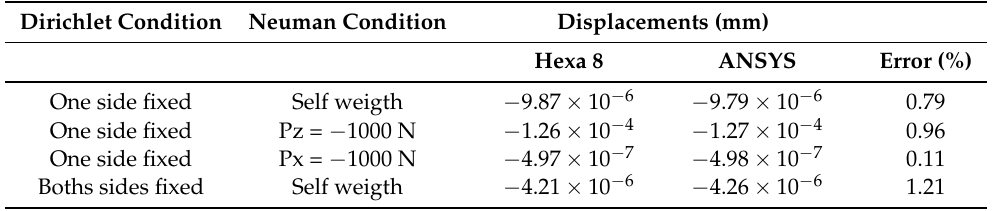
Table 1. Error between ANSYS and Hexa 8